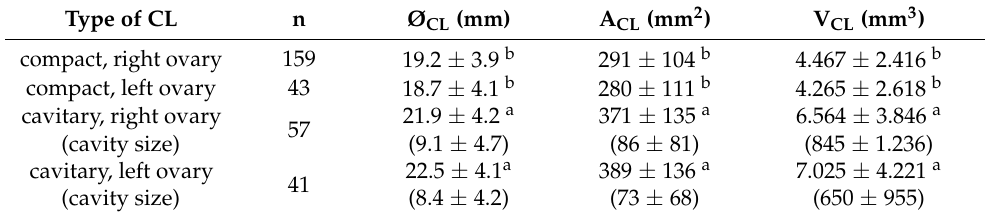
Table 3. Variability in parameters of CLs on the left and right ovaries on days 6–8 after oestrus. Type of CL